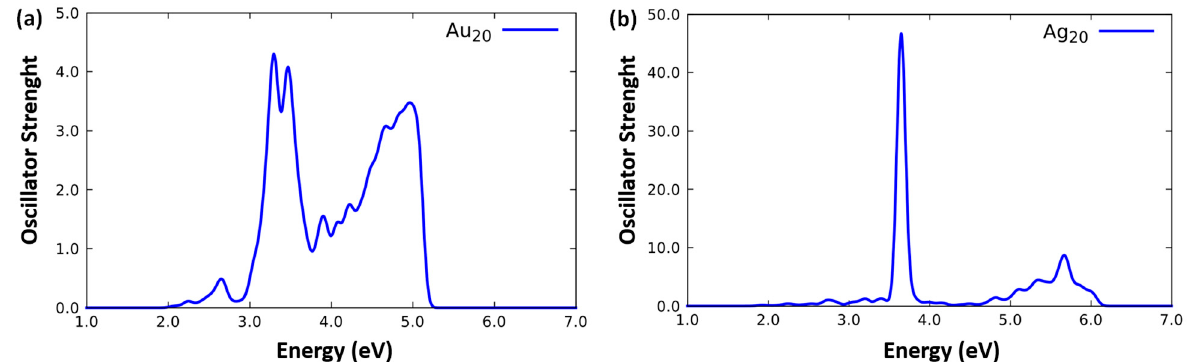
Figure 1. Simulated TDDFT/PBE0 photo-absorption spectrum of: ( a ) Au 20 and ( b ) Ag 20 simulated at the TDDFT level on their relaxed geometries using the ORCA code.